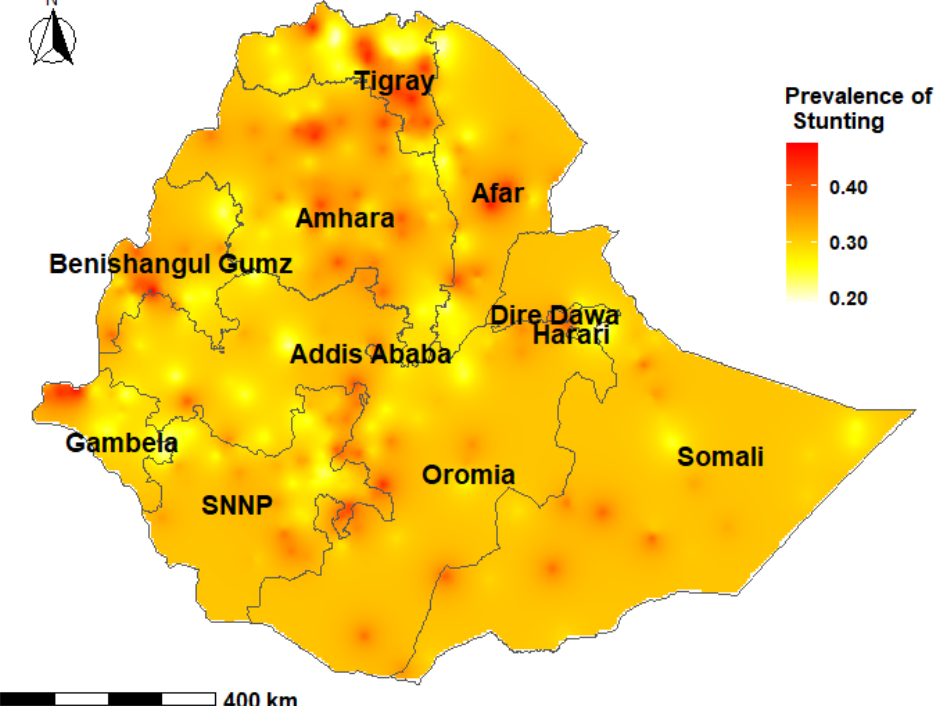
Figure 2. Predicted prevalence of stunting among children 0–23 months of age in Ethiopia, 2016 EDHS.